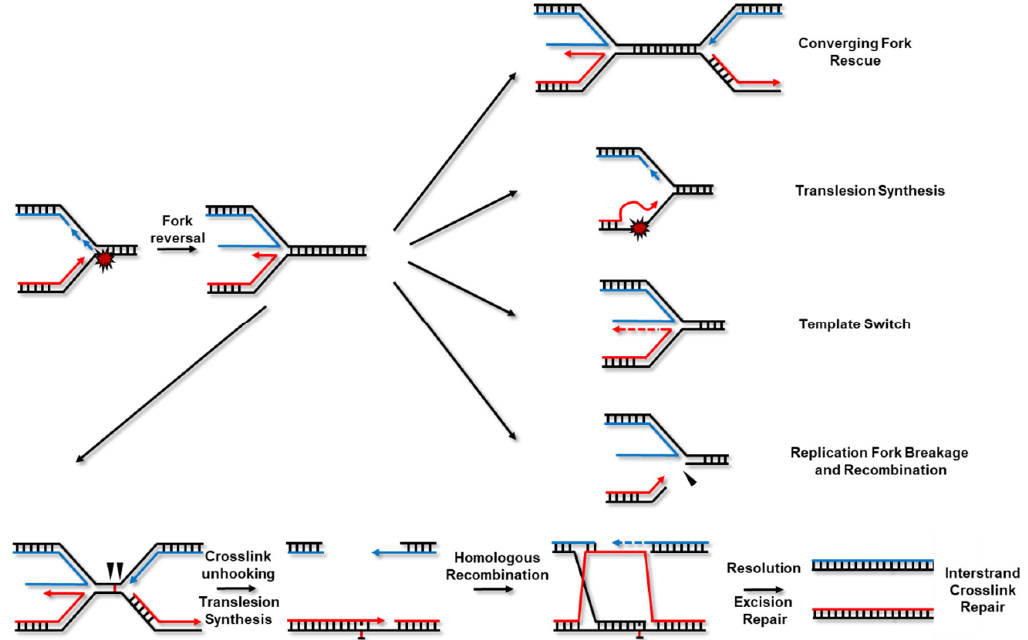
Figure 1. Replication fork Reversal and Restart Pathways. Stalled forks are rapidly reversed into four-branched structures by the combined activities of multiple DNA helicases. Stalled forks can be rescued by a converging fork arising from a nearby‐fired origin or by activation of a local dormant origin by the replication stress response. In the event of replication fork stalling due to damaged bases, error‐prone translesion polymerases can replicate past the problematic lesions. Alternatively, stalled polymerases can use an undamaged template to support genome replication, most often this template is the newly‐synthesized strand on the sister chromatid. Stalled forks can also be nucleolytically processed (isosceles triangle) to yield single‐ended DSBs that are repaired by recombination‐based pathways. The best characterized inter‐strand cross‐link repair mechanism requires the convergence of two replication forks at the lesion but replication‐independent repair can also occur. Single replication forks frequently traverse cross‐links which allows post‐replicative repair of the lesion. Nucleases (isosceles triangles) incise a single DNA strand in 5′ and 3′ of the cross‐link thereby creating a double‐strand break (DSB) concomitantly with cross‐link unhooking. Translesion synthesis proceeds past the unhooked cross‐link and homologous recombination with the sister chromatid repairs the DSB.